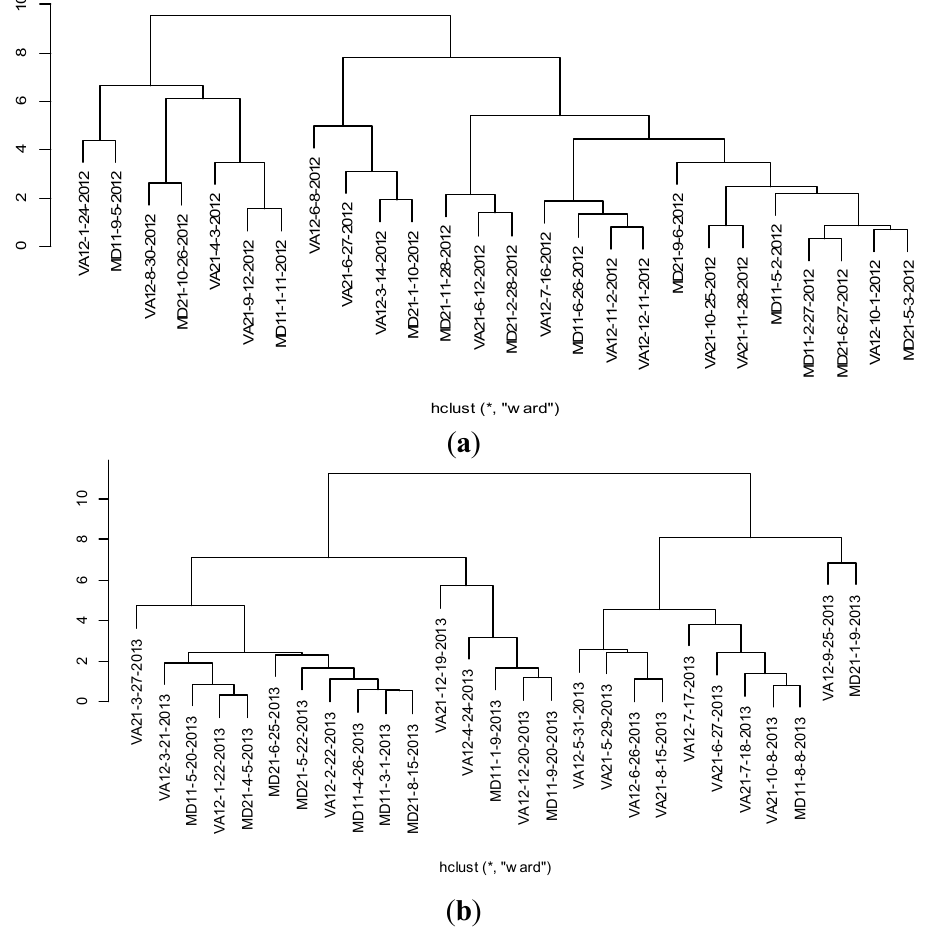
Figure 6. Dendrograms showing hierarchical clustering of water quality differences at surface level in four reservoirs ( a ) in 2012 and ( b ) in 2013. Each label represents the reservoir name (VA12, VA21, MD11 and MD21) and the sampling